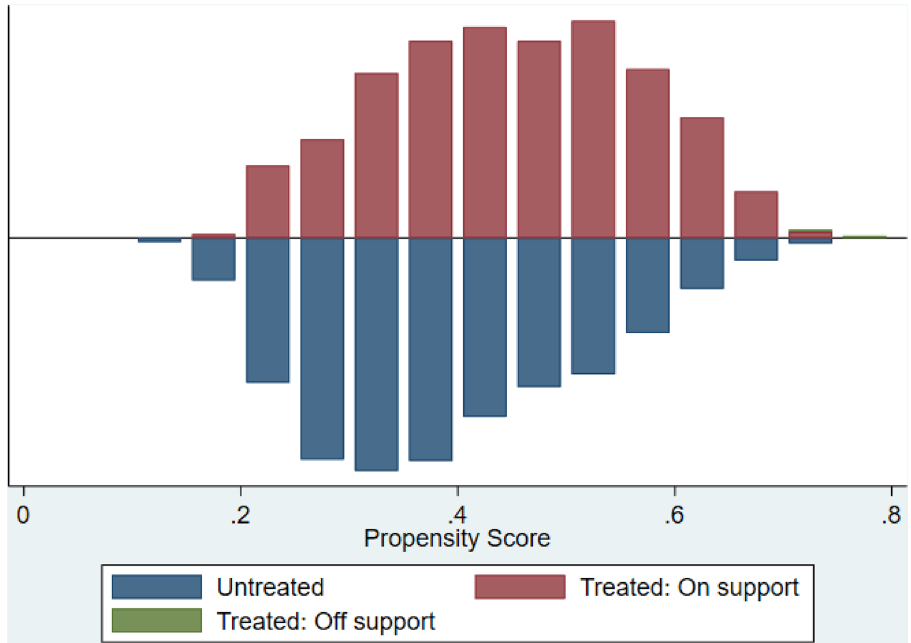
Figure 3. Graphical representation for the propensity matching score.